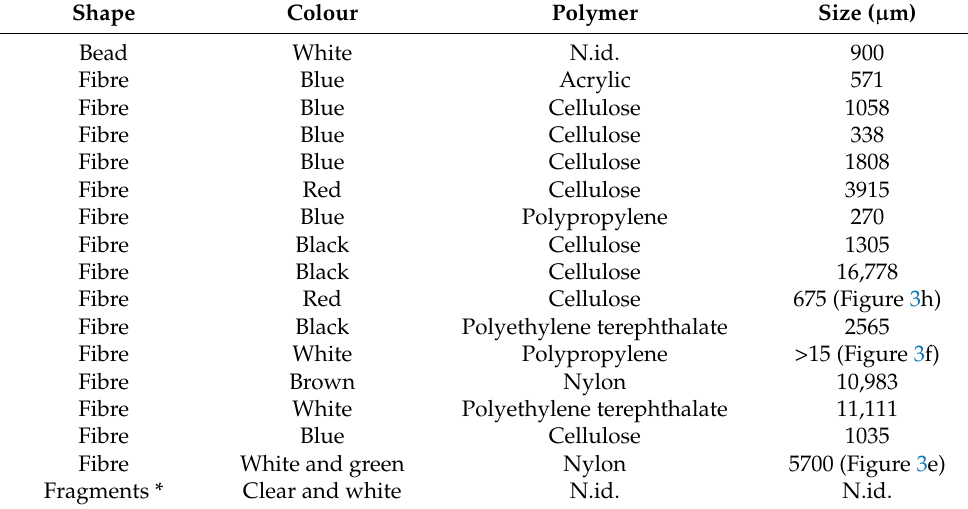
Table 3. Anthropogenic debris identified using µ -FTIR. N.id.: it was not possible to identify because they were too small or they were lost when sent for laboratory